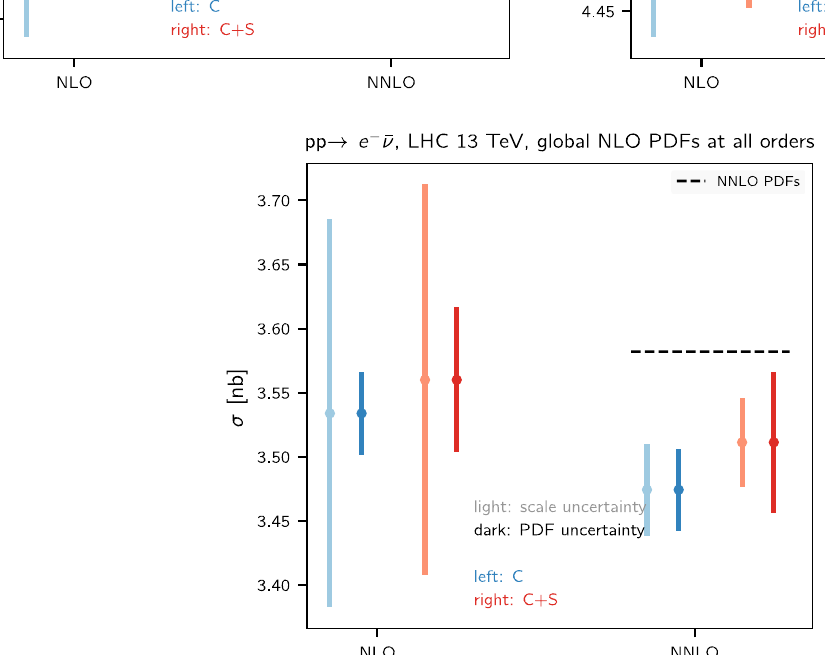
√ s = 13 TeV, see also Table